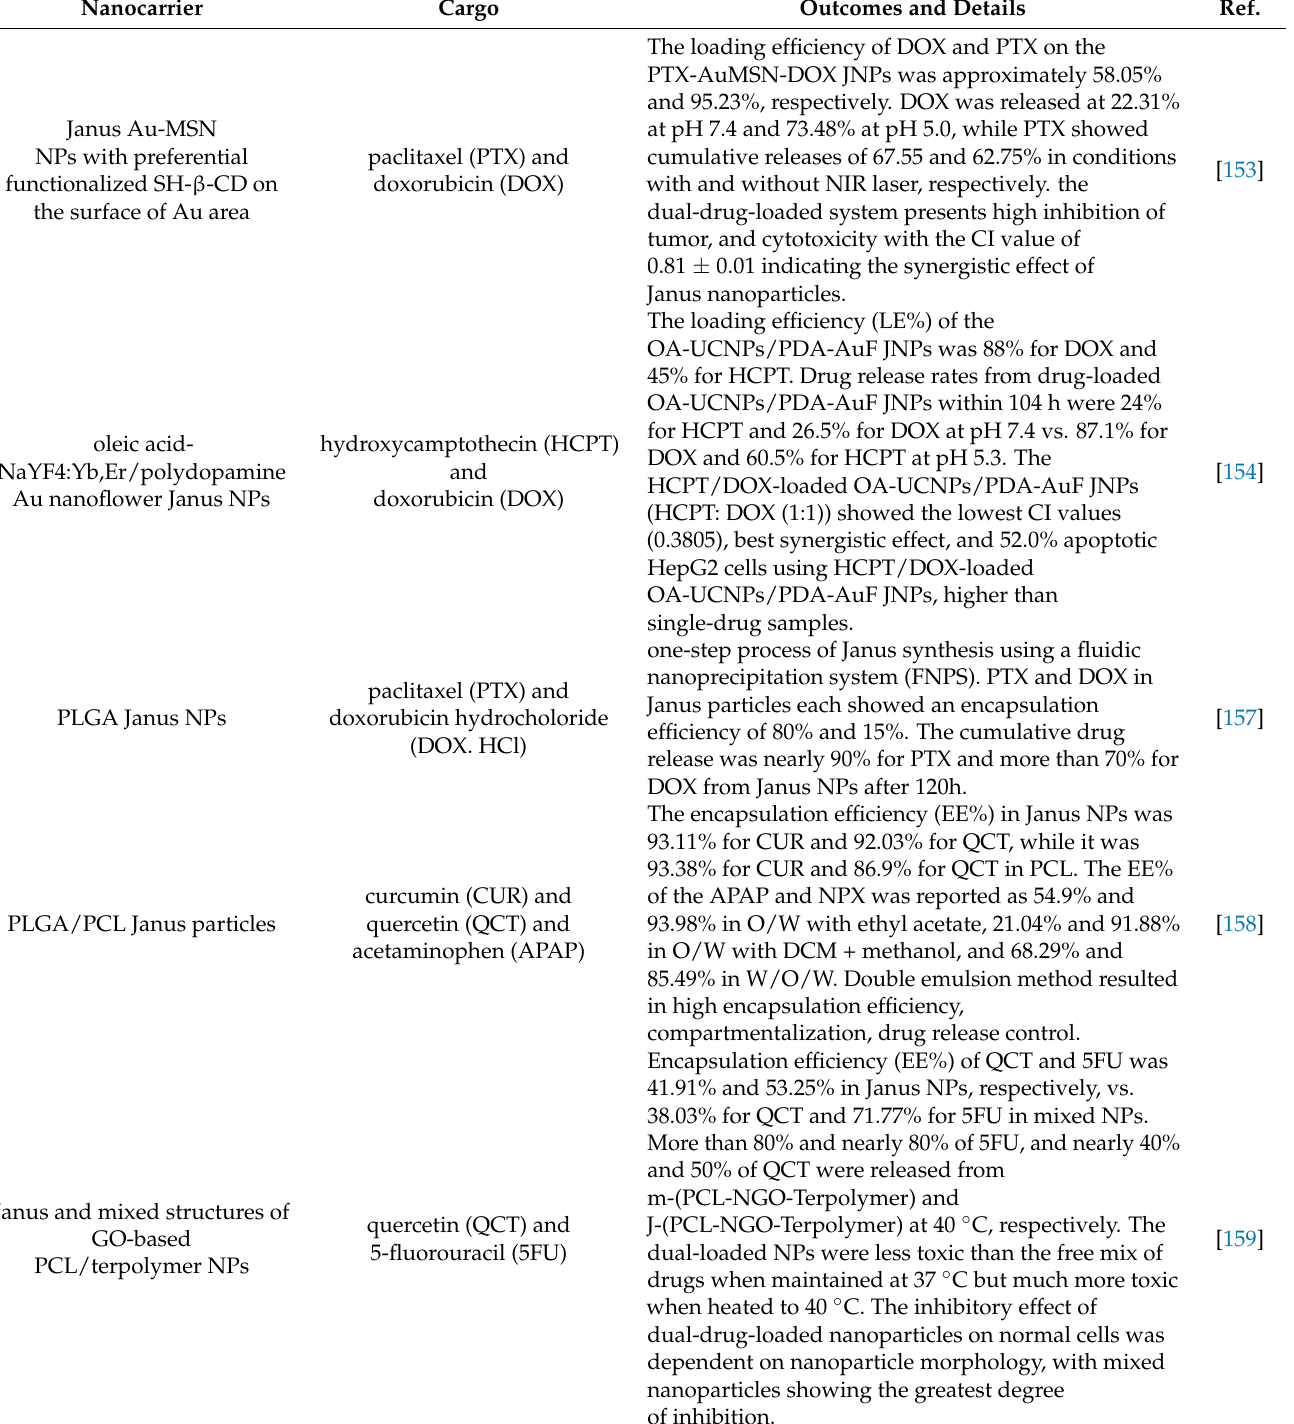
Table 2. Anisotropic structure dual delivery data in a